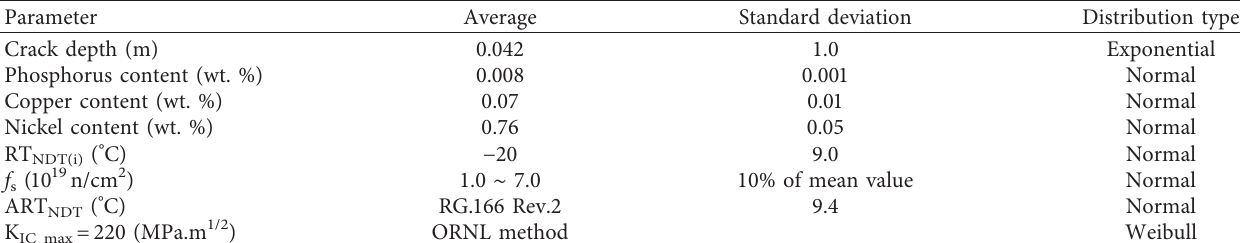
Table 2: Main random parameters of SA508 Class 3